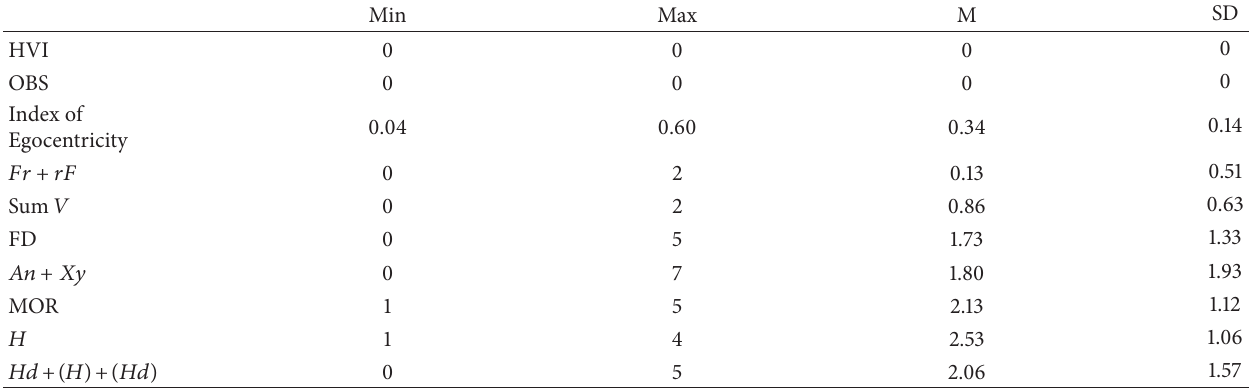
Table 1: Means and standard deviations for variables included in cluster of